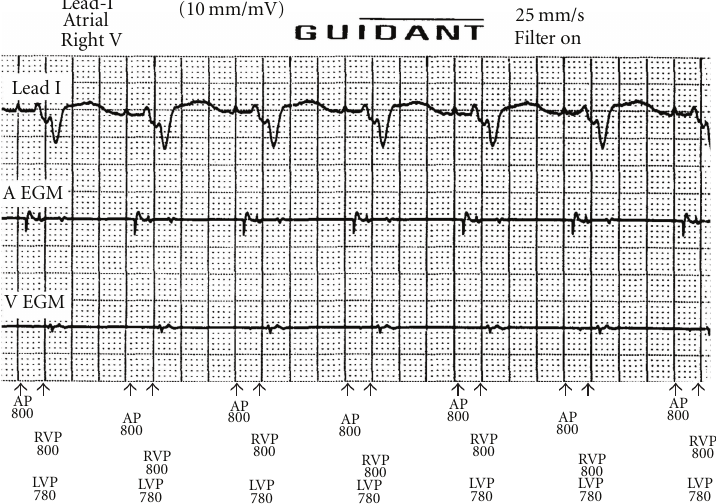
Figure 3: Restoration of normal function without cross-talk sensing after reduction of the ventricular sensitivity to the least sensitive setting. Abbreviations are similar to Figure